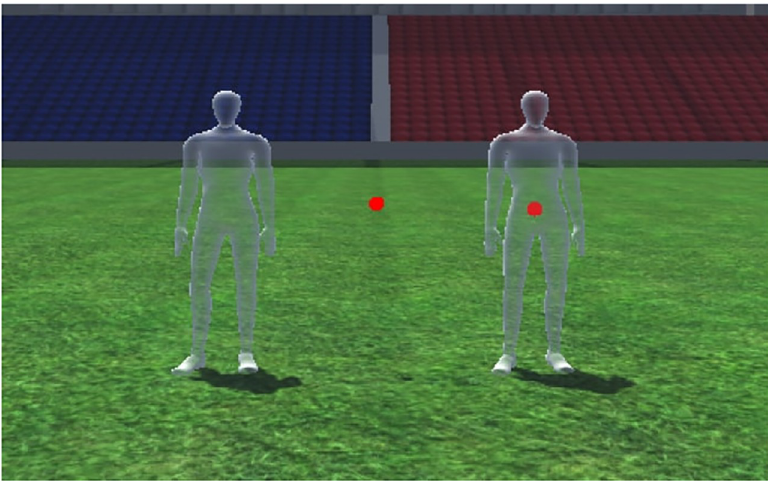
Fig 2. Visual appearances of stimuli. Visual appearances of stimuli: full body (left), center of gravity (center), full body and center of gravity combined (right).